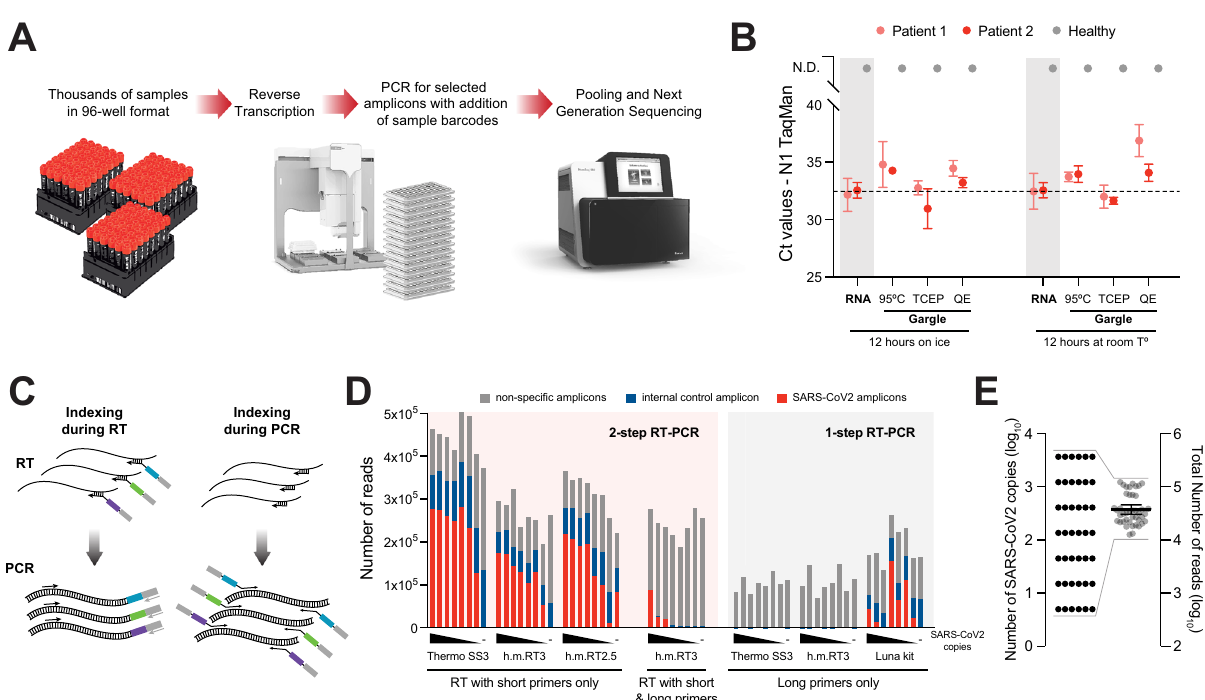
Fig. 1 Two-step RT-PCR coupled to NGS allows speci fi c detection of SARS-CoV-2 from crude respiratory samples. A Overview scheme to illustrate the envisioned analysis pipeline. B Comparative analysis of SARS-CoV-2 detection by TaqMan RT-qPCR on the N1 amplicon, following different sample preparation treatments. Gargle samples from two SARS-CoV-2-positive and one negative person were collected in HBSS. RNA was puri fi ed or crude lysates were produced using either heat inactivation for 30 min 22 , TCEP/EDTA (HUDSON buffer) 29,30 , or QuickExtract 31 . Equivalent amounts of each treated samples were incubated overnight at room temperature or on ice to assess stability. Data are plotted as mean and SD of three replicates for each positive sample; n = 1 for each condition for the negative sample. C Illustration of amplicon indexing either during RT or PCR. Colored boxes